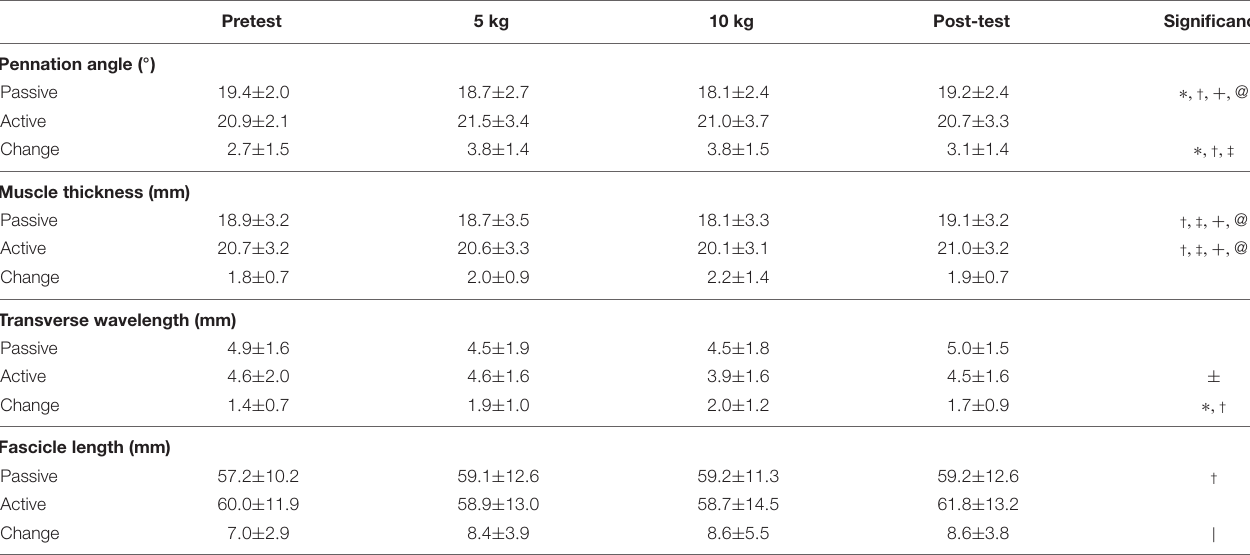
TABLE A1 | Comparison of the resting passive and peak active values between trials. Pretest 5 kg 10 kg Post-test